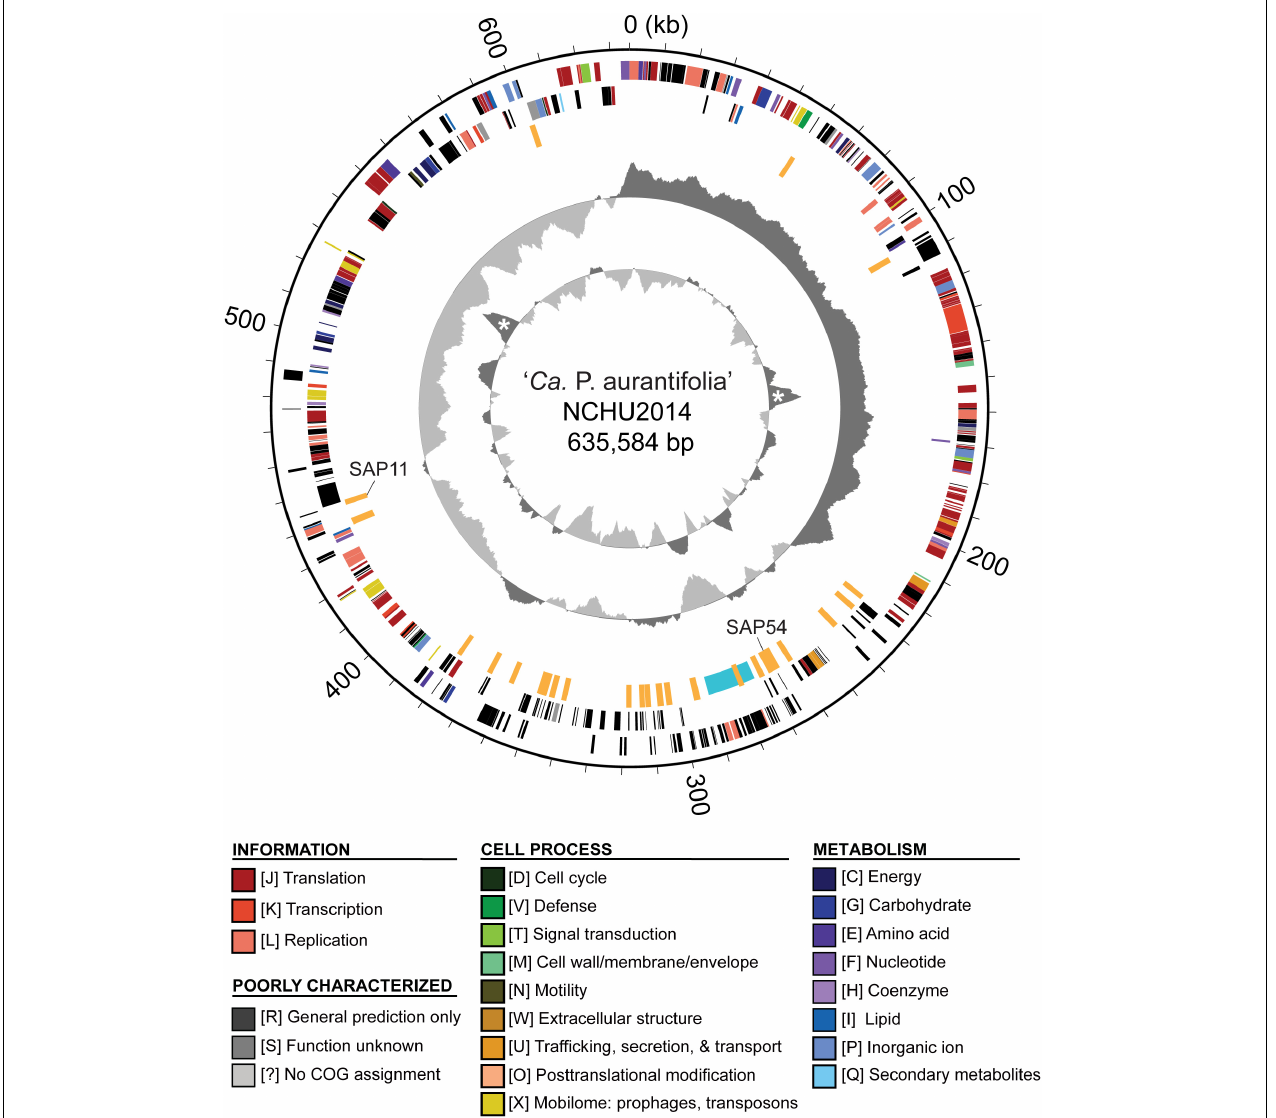
FIGURE 2 | Genome map of ‘ Ca . P. aurantifolia’ NCHU2014. Rings from outside in: (1) scale marks; (2 and 3) coding sequences on the forward and reverse strand, respectively (color-coded by functional categories); (4) putative effectors (orange) and putative mobile unit (light blue); (5) GC skew (positive: dark gray; negative: light gray); (6) GC content (above average: dark gray; below average: light gray), two peaks corresponding to the rRNA operons are marked by